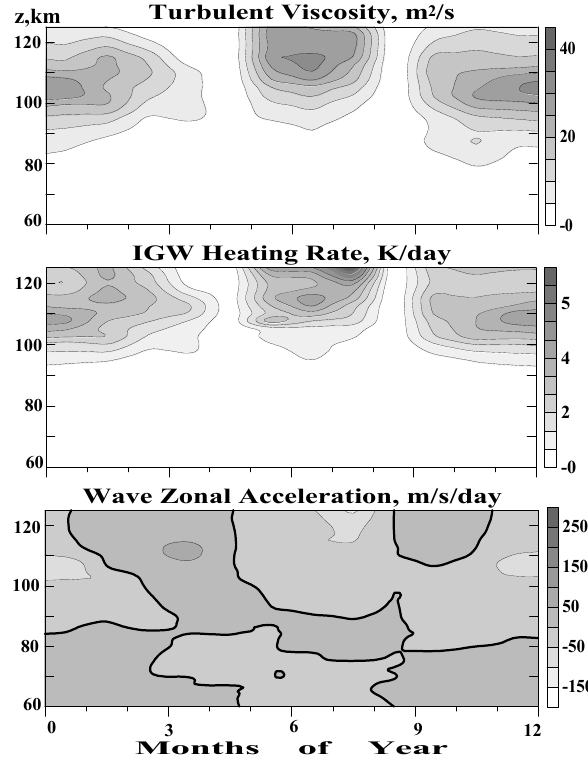
Fig. 8. Same as Fig. 7, but for IGW sources located below altitude Fig. 9. Same as Fig. 7, but for IGW sources located above altitude 20km. Fig. 9. “Gavrilov and Jacobi, A study of seasonal…” Fig. 8. “Gavrilov and Jacobi, A study of seasonal…”